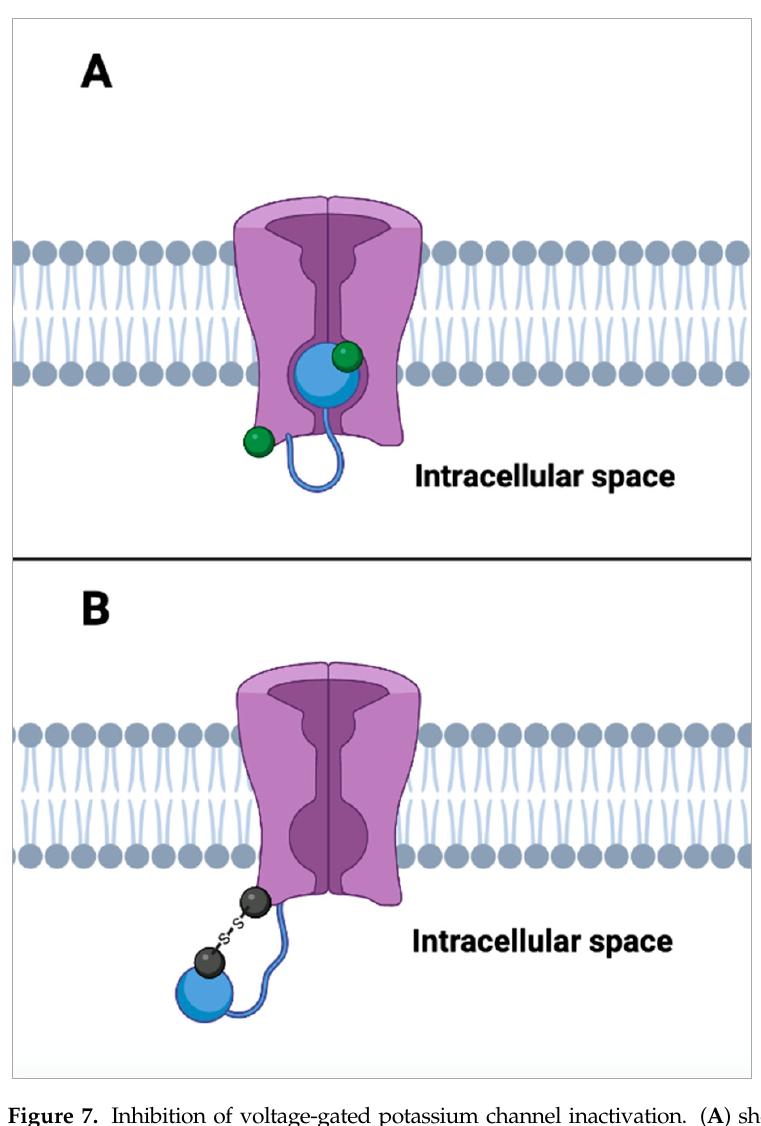
Figure 7. Inhibition of voltage-gated potassium channel inactivation. ( A ) shows a voltage gated K + channel (in purple) in a state of inactivation. This state occurs when an auto-inhibitory peptide (blue ball) that is tethered to the N-terminus of the K + channel binds to the open channel pore by compet- ing with intracellularly applied channel blockers [90]. When cysteine residues located on both the blocking peptide and the channel itself are in their reduced state (green ball), inactivation activity is